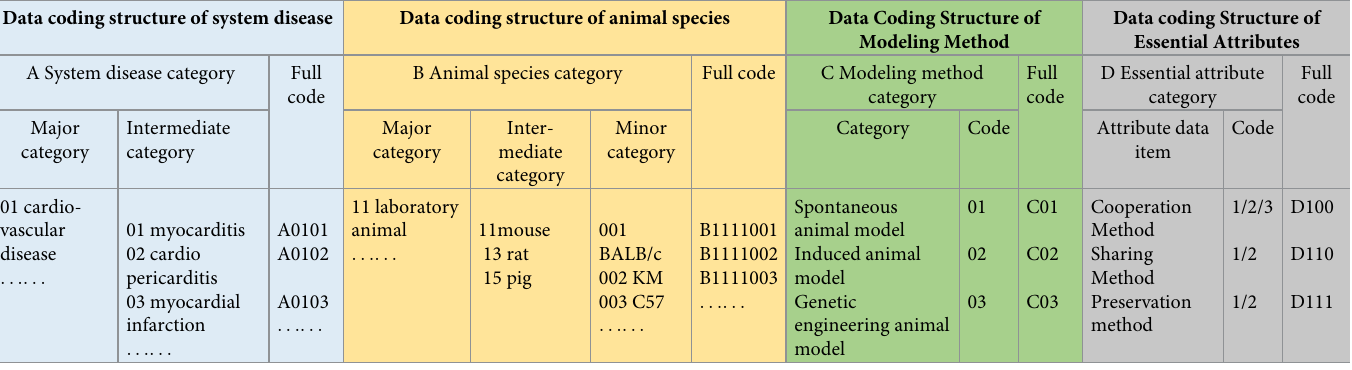
Table 2. Data coding structure of animal